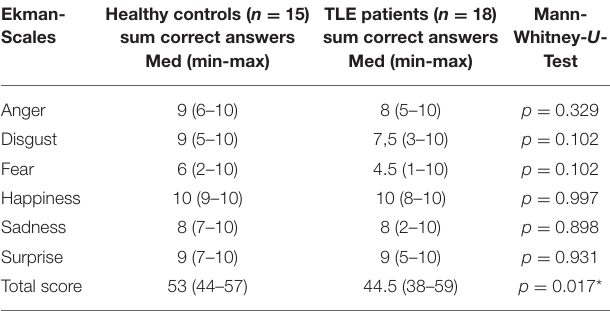
TABLE 5 | Results of each group on the Ekman 60 Faces Test. Ekman- Healthy controls ( n = 15) Scales sum correct answers